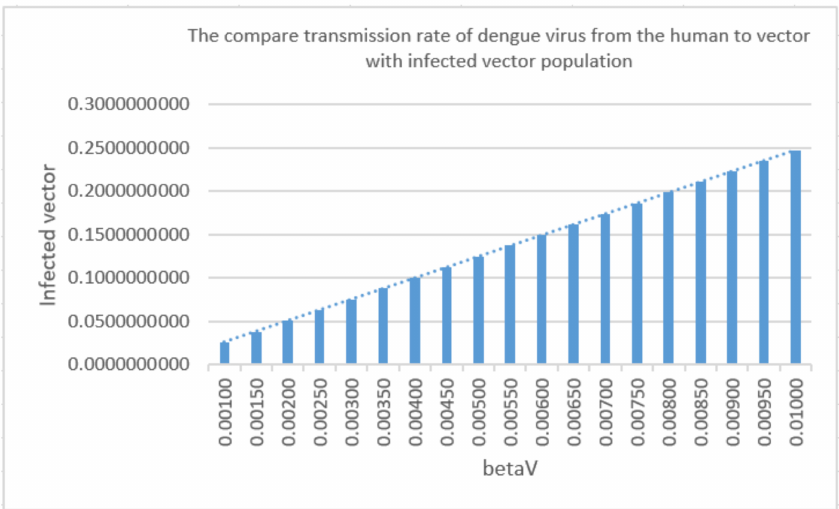
Figure 10. A comparison of parameters between β V with I V ∗